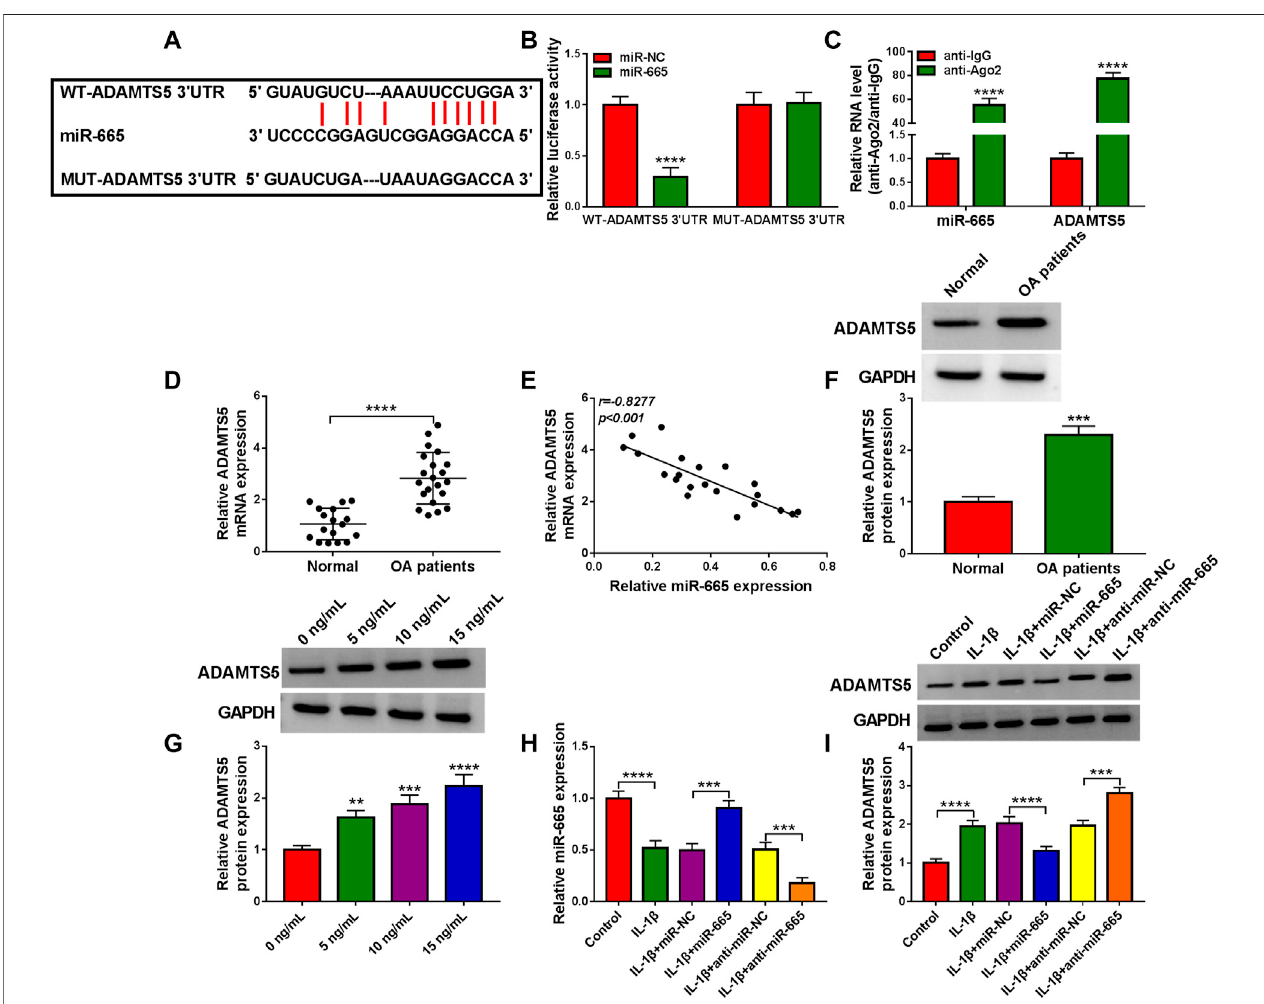
FIGURE 5 | miR-665 is directly targeted by ADAMTS5. (A) Binding between ADAMTS5 and miR-665 was analyzed using Starbase software. (B,C) The binding wasvalidated using a dual-luciferase reporter assay and RIP assay in CHON-001 cells (**** indicates p < 0.0001 relative to the miR-NC group or the anti-IgG group). (D) ADAMTS5 expression was determined in 21 OA cartilage tissues and 17 healthy cartilage tissues using RT-qPCR assay (**** indicates p < 0.0001 relative to the control group). (E) The expression correlation between miR-665 and ADAMTS5 in OA cartilage tissues was analyzed by Pearson correlation analysis. (F) ADAMTS5 protein level was measured in 21 OA cartilage tissues and 17 healthy cartilage tissues using western blot assay (GAPDH was used as a loading control) (*** indicates p < 0.001relativetothecontrolgroup). (G) WesternblotanalysisofADAMTS5proteinlevelinCHON-001cellstreatedwithvariousdosesofIL-1 β ,andGAPDH wasusedasaloadingcontrol(**,***or****indicates p < 0.01, p < 0.001,or p < 0.0001relativetothe0 ng/mlIL-1 β groups). (H,I) CHON-001cellsweretreatedwithIL-1 β , IL-1 β + miR-NC, IL-1 β +miR-665, IL-1 β +anti-miR-NC, IL-1 β +anti-miR-665, or without (Control), then, miR-665 level was assessed using RT-qPCR assay and ADAMTS5 protein level was measured using western blot assay (**** indicates p < 0.001 when IL-1 β group was compared to the negative control group and *** or **** indicates p < 0.001 or p < 0.0001 when IL-1 β +miR-665 group was compared to the IL-1 β + miR-NC group and *** indicates p < 0.001 when IL-1 β +anti-miR-665 group was compared to the IL-1 β +anti-miR-NC group). These results were presented as the mean ± (SD), n = 3.